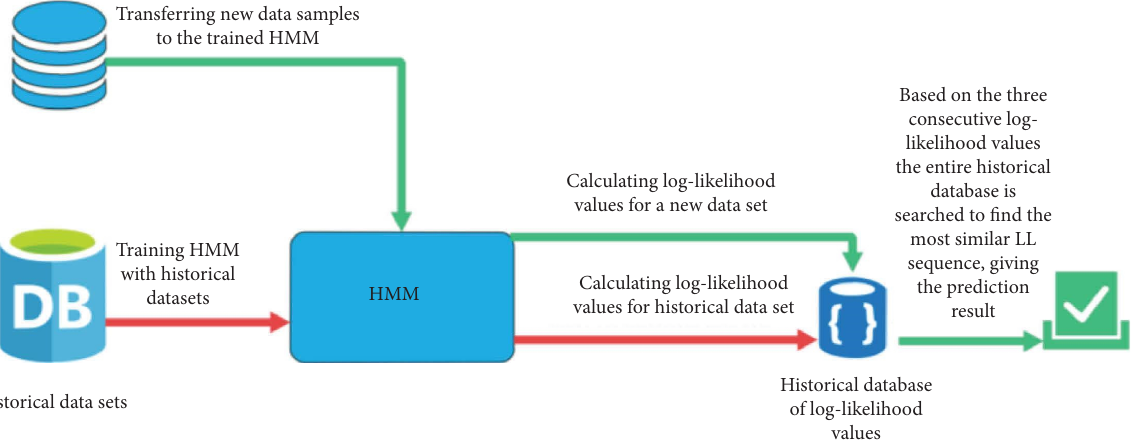
Figure 7: Reduction method based on LL